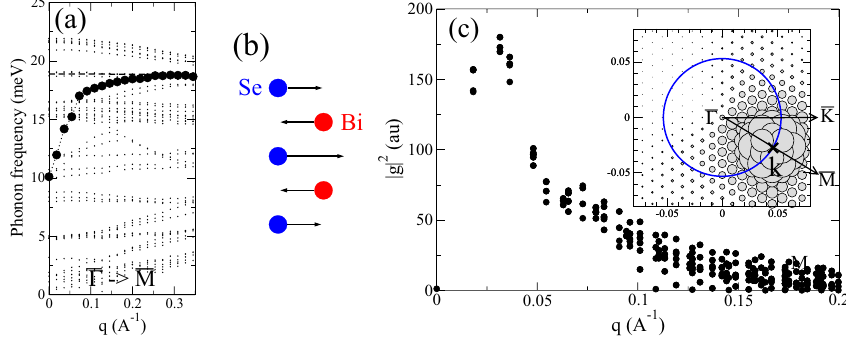
Figure 3. ( a ) Phonon dispersion of the 3QL slab of Bi 2 Se 3 in the vicinity of Γ along the Γ M direction. Circles highlight the longitudinal branch of the in-plane polar-type mode. ( b ) Displacement pattern of the same mode. ( c ) Dependence of the squared electron-phonon matrix elements, | g | 2 , on the modulus of the momentum transfer q , for a fixed initial state along Γ M , as carried by the in-plane polar-type vibration. The inset shows the 2 for an initial state along with momentum k (position is indicated by full 2D momentum dependence of | | g + k q k , the cross) as function of the final momentum k + q . The size of the filled circles is proportional to g 2 . The blue circle indicates states with the same energy as the initial